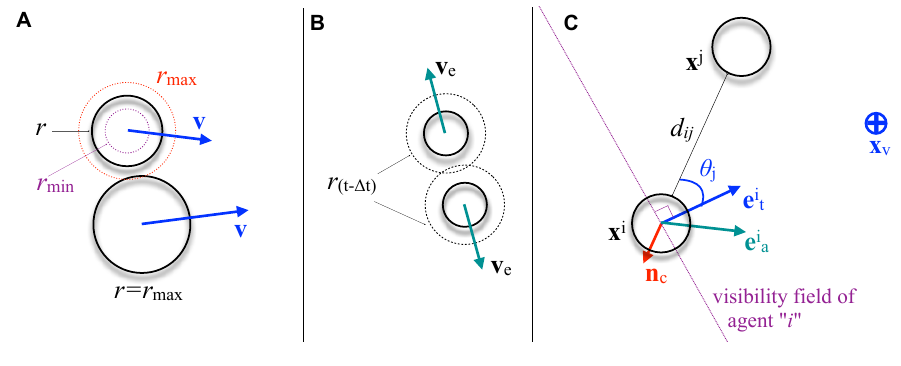
Figure 1: Contractile particle model. A: Two particles without contact. B: The radii of two particles that overlapped in the previous time step (dashed circles) collapse, and the particles take the escape velocity. A and B correspond to the original CPM. C: Modification considering an avoidance direction.